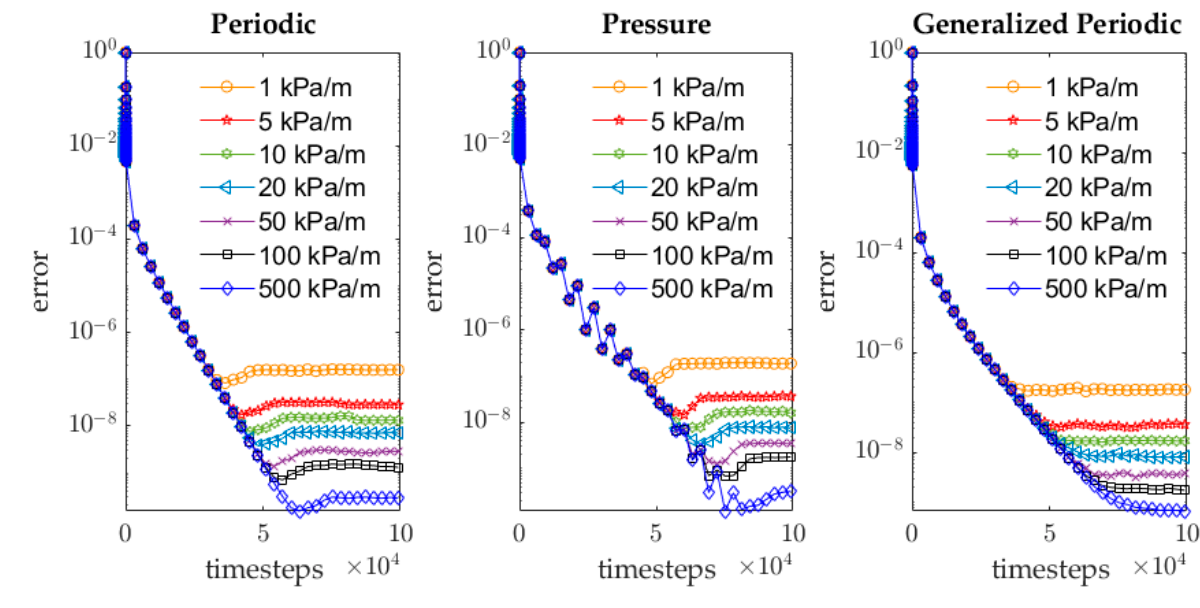
Figure 14. Convergence behavior in domain D2.